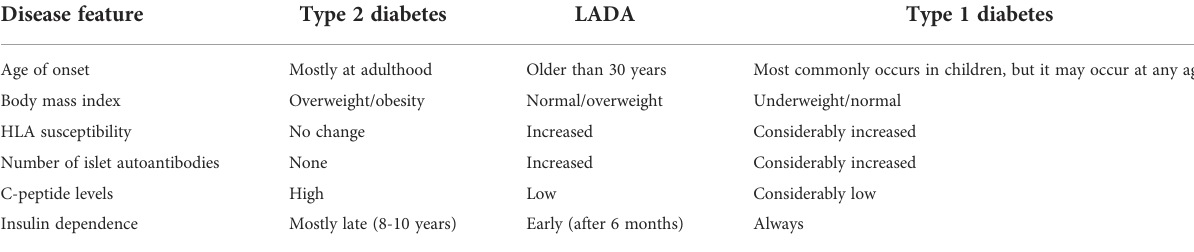
TABLE 1 Differences in key parameters between type 1 diabetes, LADA, and type 2 diabetes.